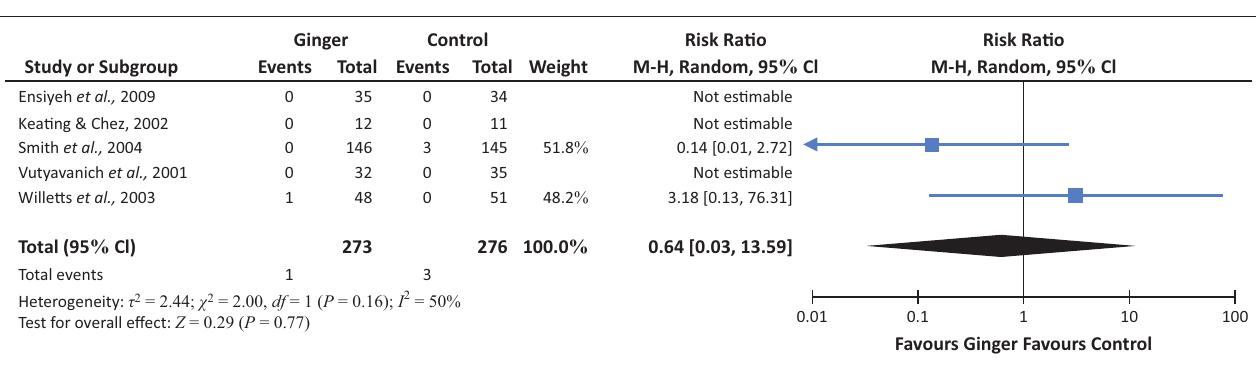
FIGURE 4: Incidence of stillbirth.